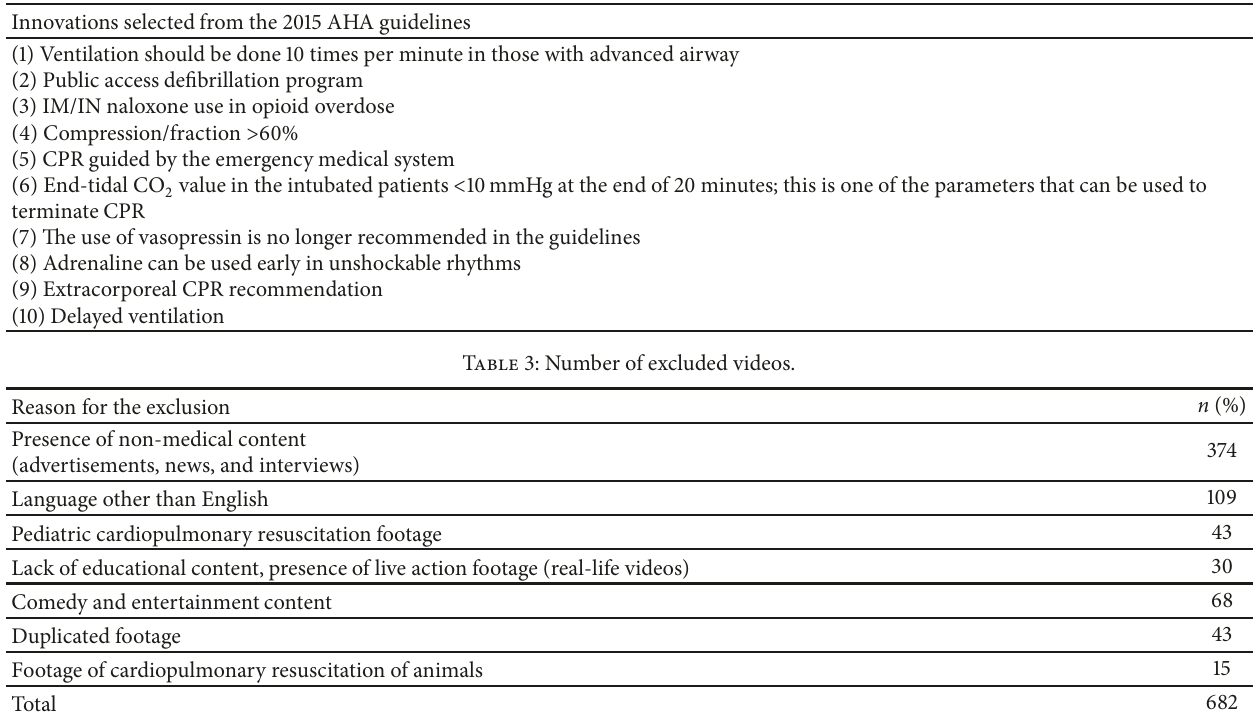
Table 2: Selected innovations mentioned in the 2015 American Heart Association guidelines used for video evaluation.